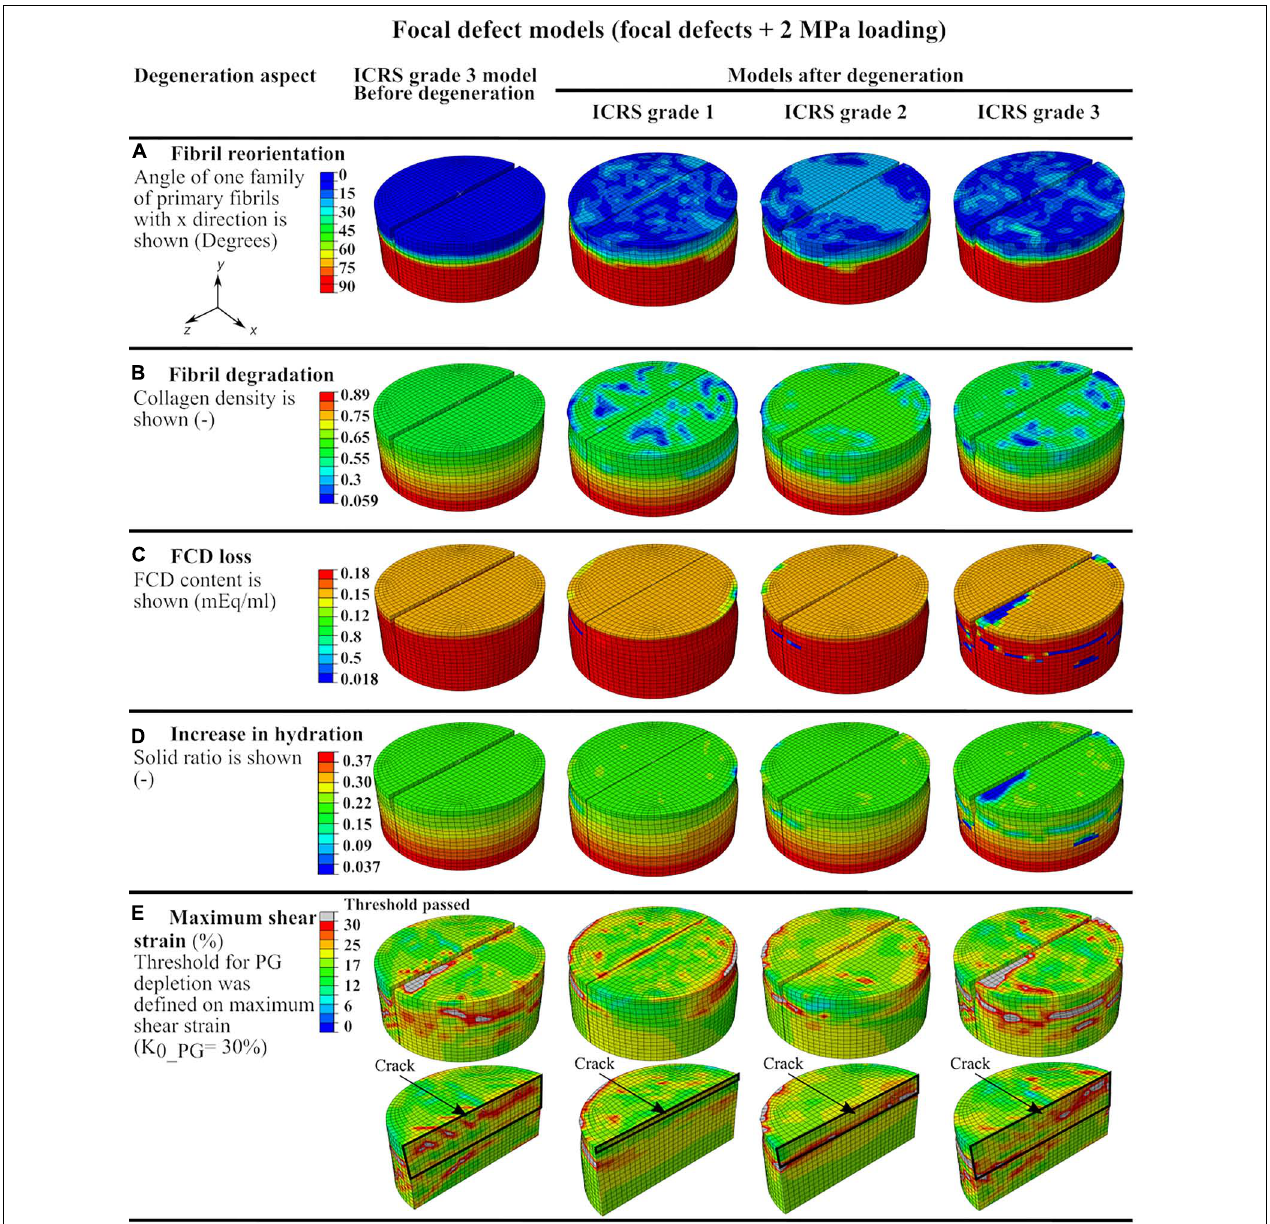
FIGURE 4 | The defect model results showing color maps of degeneration aspects of the CARED model before degeneration (only for ICRS grade 3 model) and after degeneration (for the three ICRS grades models): (A) fibril reorientation, (B) fibril degradation, (C,D) the FCD loss and the increase in the tissue hydration and (E) the maximum shear